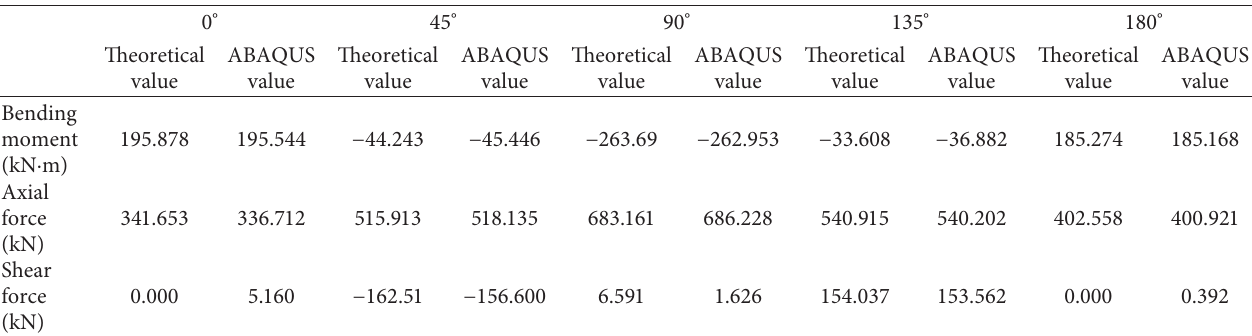
Figure 9: Comparison of numerical simulation and theoretical model analysis results. (a) Bending moment. (b) Axial force. (c) Shear force. Table 8: Comparative analysis of the results of ABAQUS and the theoretical analysis of the